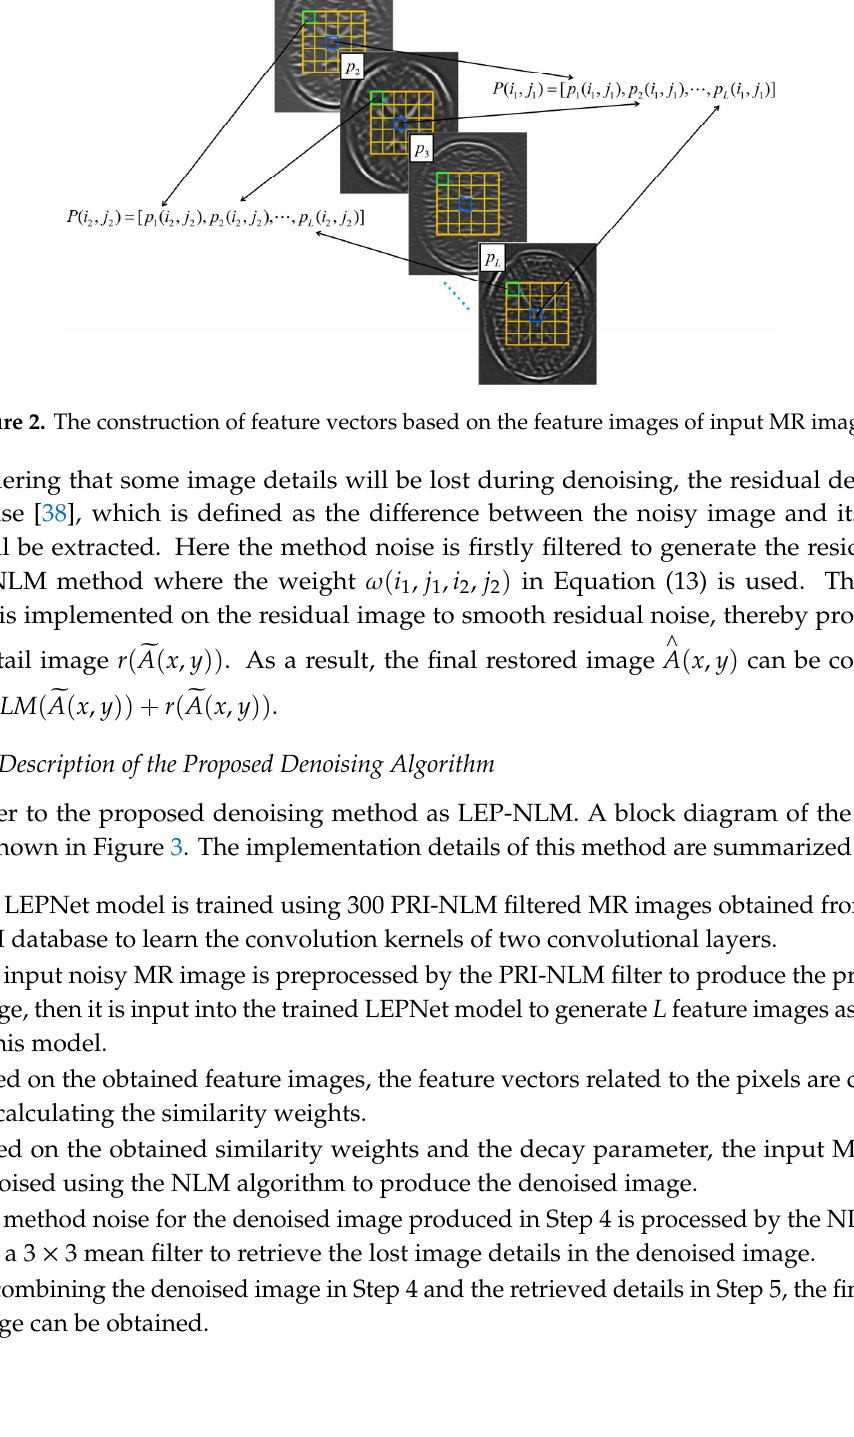
Figure 3. Block diagram of the proposed denoising method.